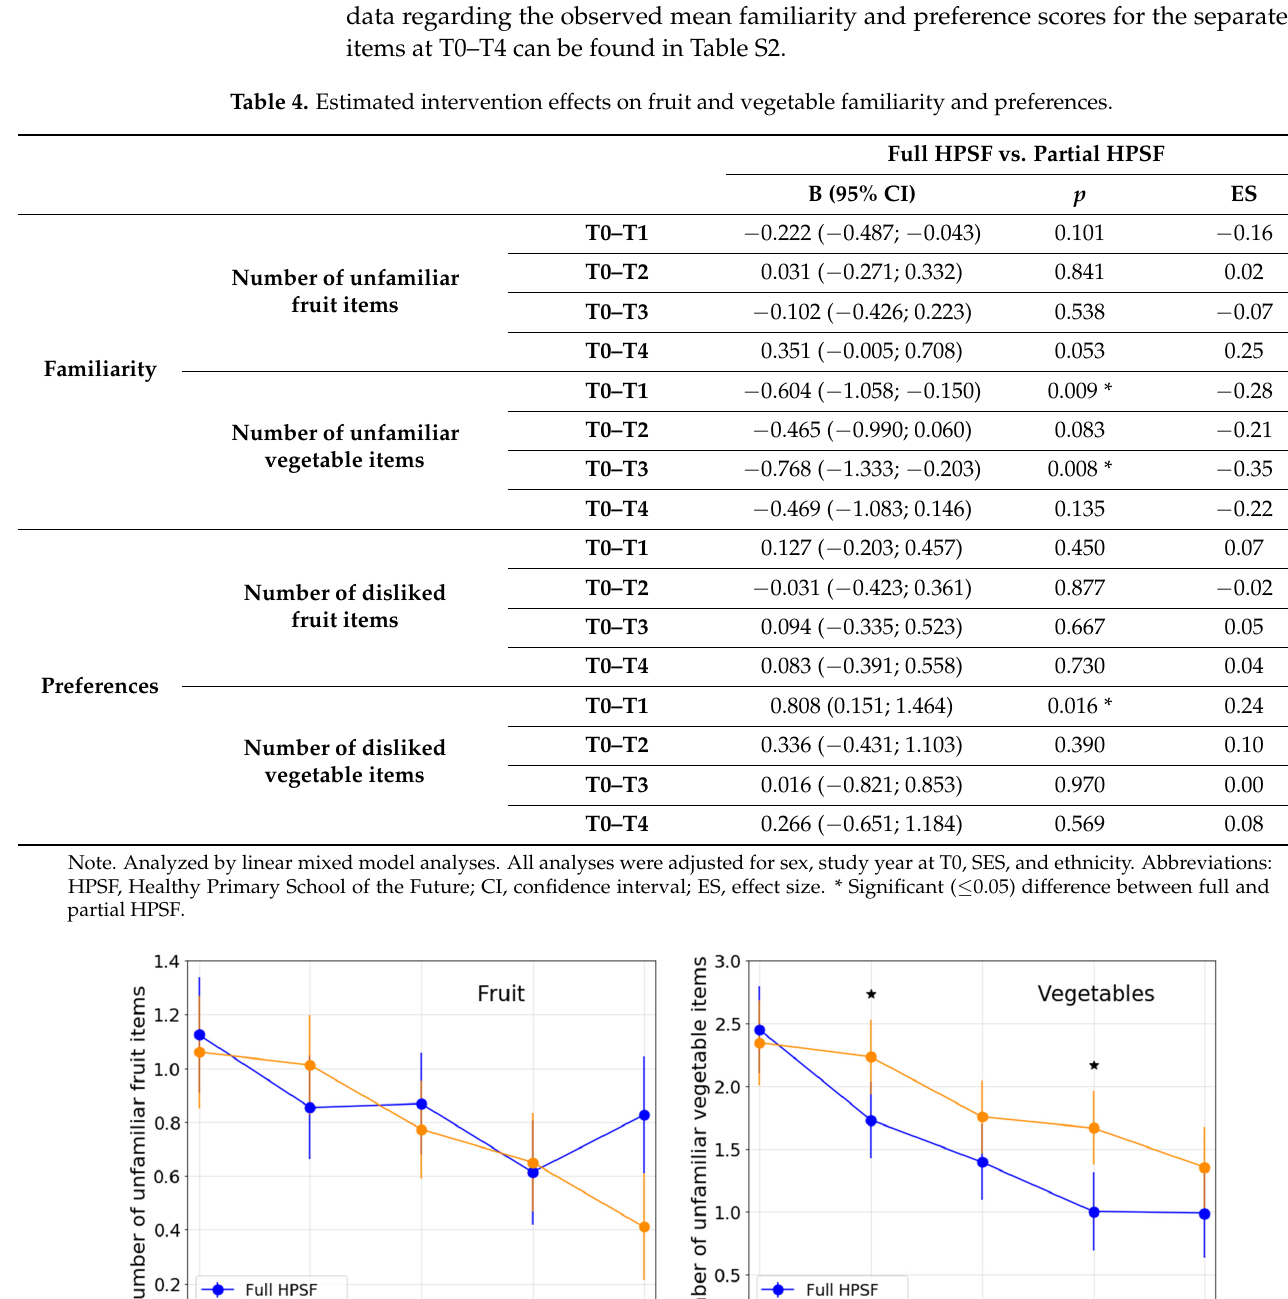
( b ) Figure 3. Estimated means of children’s fruit and vegetable preferences at T0–T4: ( a ) Number of disliked fruit items; ( b ) Number of disliked vegetable items. Note. All analyses were adjusted for sex, study year at T0, SES, and ethnicity. Abbre- viations: HPSF, Healthy Primary School of the Future. ★ Significant ( ≤ 0.05) difference between full and partial HPSF after correction for baseline.